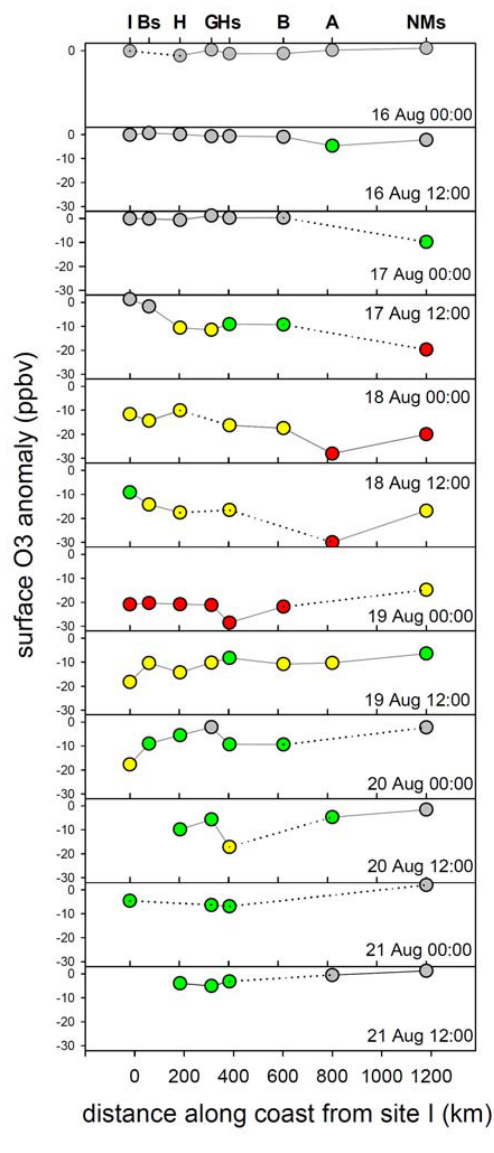
Fig. 8. Surface ozone anomaly (i.e. difference in mixing ratio) at Figure 8. Surface ozone anomaly (i.e. difference in mixing ratio) at each site relative to the 12 hour 609 each site relative to the 12 h average at that site before depletion average at that site before depletion began, plotted at 12 hour intervals, as a function of distance 610 began, plotted at 12 h intervals, as a function of distance around the around the coast from Site I. Colour coding emphasises amount of ozone loss – grey: 0 to 2.5 ppbv; 611 coast from Site I. Colour coding emphasises amount of ozone loss green: 2.5 to 10 ppbv; yellow: 10 to 20 ppbv; red: more than 20 ppbv. Positions of the autonomous 612 – grey: 0 to 2.5ppbv; green: 2.5 to 10ppbv; yellow: 10 to 20ppbv; sites are indicated on the top axis; Bs, Hs, and NMs are Belgrano II station, Halley station and 613 red: more than 20ppbv. Positions of the autonomous sites are in- dicated on the top axis; Bs, Hs, and NMs are Belgrano II station, Neumayer station respectively. Dotted lines are used when data points are missing. 614 Halley station and Neumayer station respectively. Dotted lines are 615 used when data points are